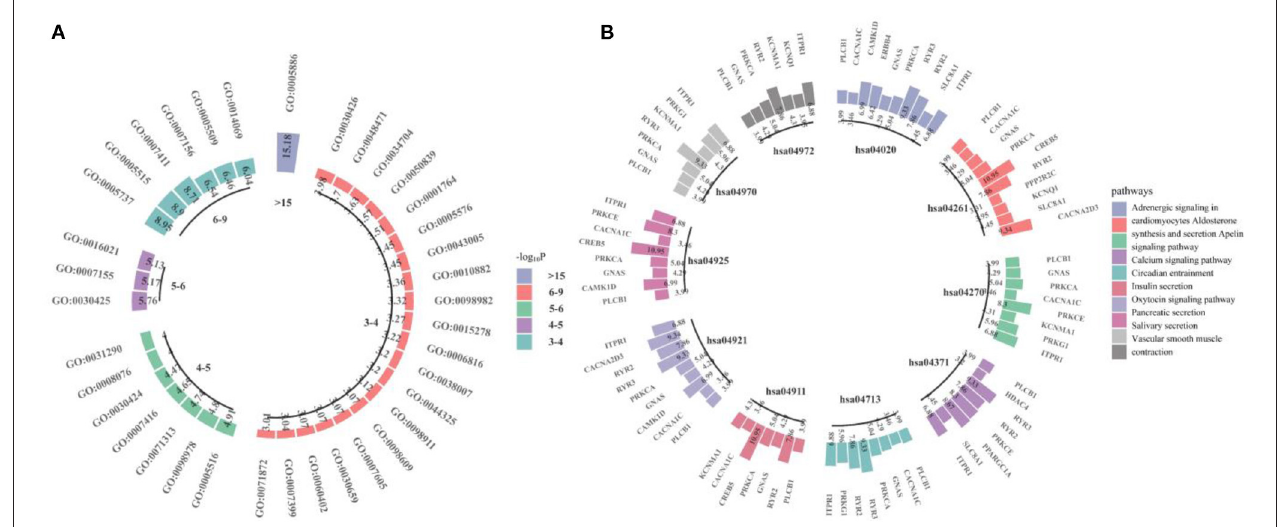
FIGURE 9 | The GO terms and top 10 pathways identify by our model. (A) is for GO terms and (B) is for pathways.